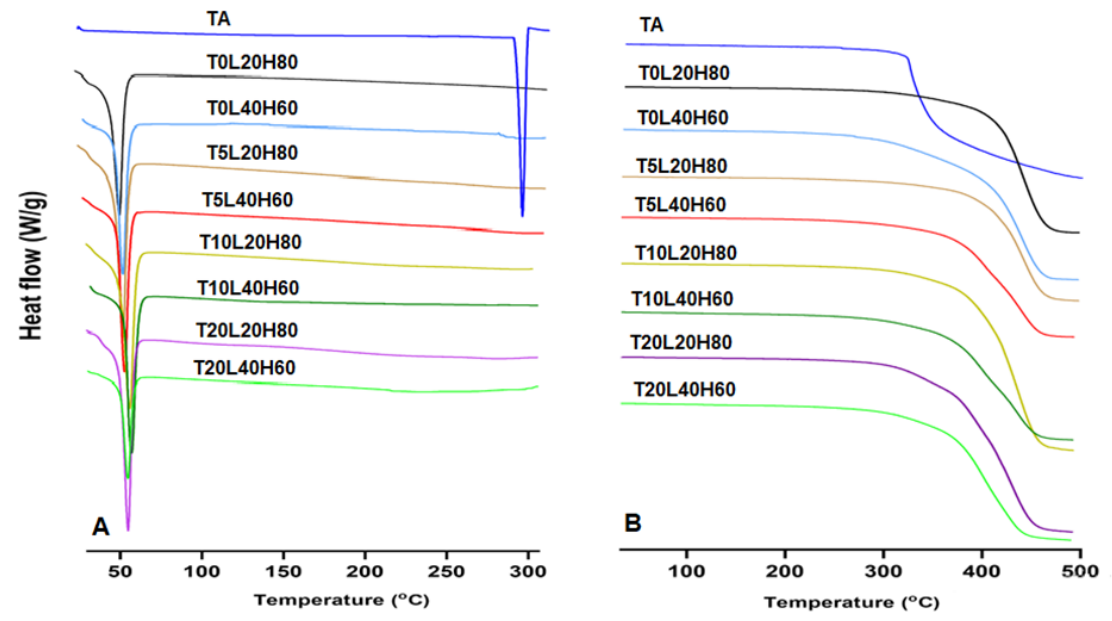
Figure 5. ( A ) DSC profile and ( B ) TGA data of pure TA, blank PCLs, and TA-loaded PCL implants.